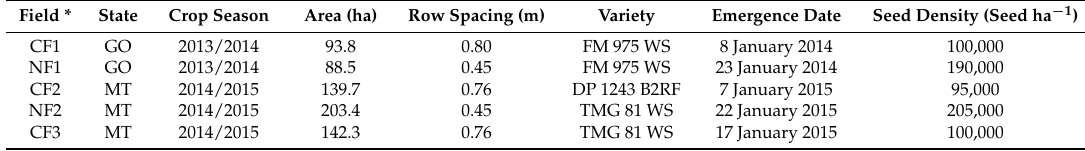
Table 1. Field and crop characteristics of areas used for data